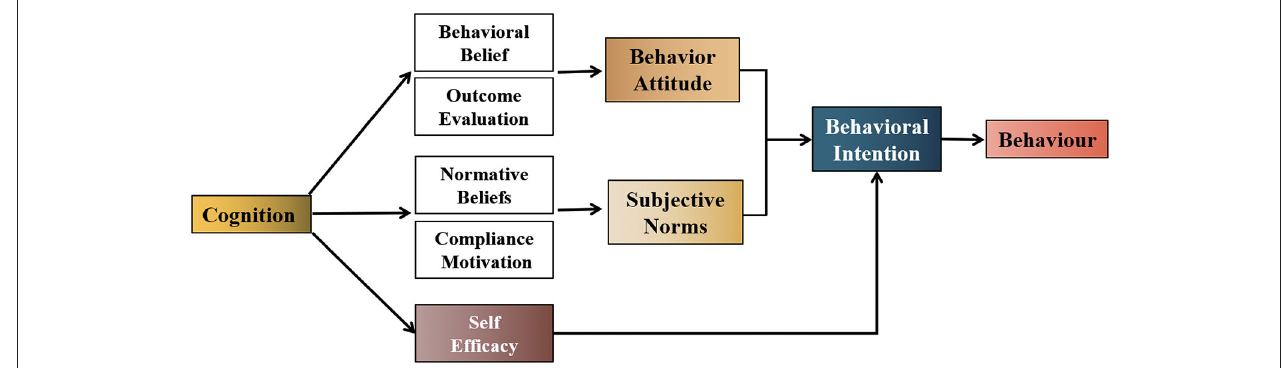
FIGURE 1 | Architecture of behavioral intentions based on planned behavior, self-efficacy, and knowledge-attitude-practice theory. Definitions: Cognition: understanding of a disease, nurses’ responsibility to care for patients, and nurses’ rights and responsibilities to participate in care. Behavioral beliefs: a person’s judgment of the likelihood of outcomes resulting from engaging in patient care. Outcome evaluation: a person’s positive or negative value judgment of outcomes resulting from engaging in patient care. Normative belief: an individual’s belief that he or she should engage in caring for patients with respect to important reference objects. Compliance motivation: the willingness of individuals to comply with important reference objects as far as patients are concerned. Behavior attitude: the positive or negative evaluation of an individual’s behavior that reflects their preference for the behavior. Subjective norms: social pressures perceived by individuals while performing behaviors that reflect the influence of important others or groups. Self-efficacy: self-assessment of ability and confidence to care for a patient in a particular situation. Behavioral intentions: a person’s subjective probability or preference for engaging in the care of